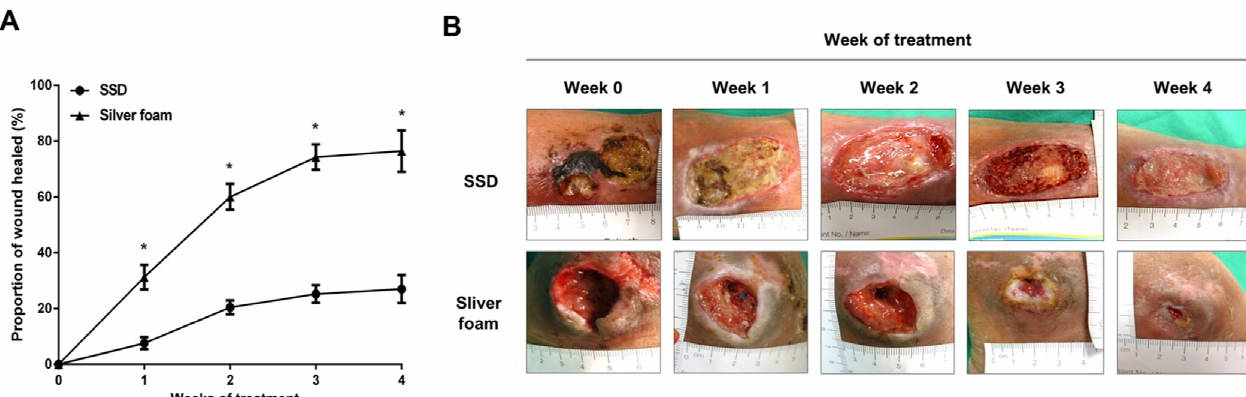
Figure 2. Silver foam dressing facilitated the DFU healing as compared with the SSD dressing. ( A ) The proportion of the wound healed was demonstrated by the percentage of the wound area reduction (week 1, week 2, week 3, and week 4) from the initial wound area at enrollment (week 0). * p -value < 0.05. ( B ) The serial follow-up of the patients who received adequate debridement and wound care with the SSD dressing (( B ), upper panel) and silver foam dressing (( B ), lower panel) in week 1, week 2, week 3, and week 4 of the